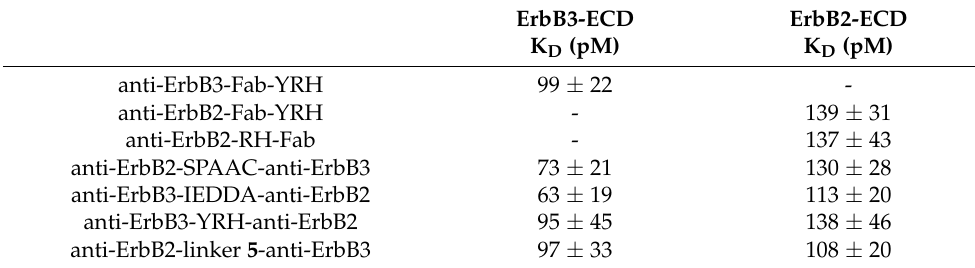
Table 1. Comparison of dissociation constants of single and bispecific ErbB2- and ErbB3-Fabs deter- mined by SPR. Biotinylated ErbB2 or ErbB3 ectodomains were immobilized separately on streptavidin sensor chips; no binding was detected. SPAAC: strain-promoted alkyne-azide cycloaddition, IEDDA: inverse electron-demand Diels–Alder